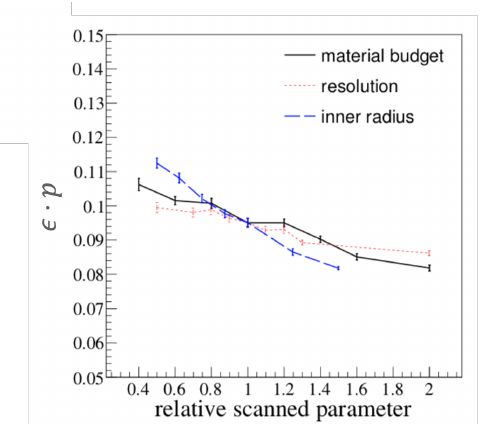
Figure 16 . The c-tagging performance with a parameter scan on the basis of the CEPC baseline. The y-axis represents the efficiency times purity of c-jets tagged in ννH, H → b ¯ b, c ¯ c, gg samples. The x-axis represents the relative difference of vertex detector parameters to the CEPC